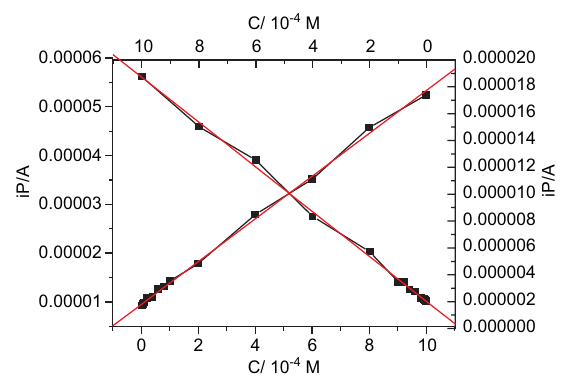
Figure 7 GU concentration vs. peak current on the bare electrode and HPM α FP/GCE.